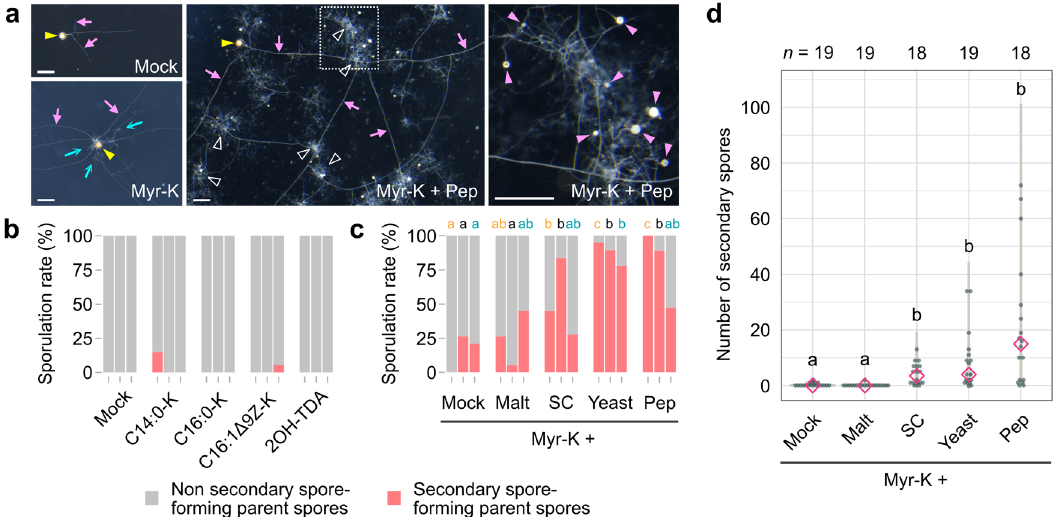
Fig. 1 Effects of fatty acid salts and organic nitrogen sources on asymbiotic cultures of R. clarus . a Effects of potassium myristate (Myr-K) and peptone (Pep) on R. clarus growth. AM fungi were incubated in a medium with or without 100 μ M Myr-K and 0.2 g l − 1 peptone for 6 weeks. Branched hyphae (blue arrows) were observed around a parent spore (yellow arrowhead) in a medium containing Myr-K. Small, white spores were formed among densely packed coils (DPCs, outlined arrowheads) in a medium containing both Myr-K and Pep. The rightmost picture is a magni fi ed image of the dotted box in the middle picture. Pink arrowheads indicate newly generated secondary spores. Pink arrows indicate runner hyphae. Bars = 500 µ m. b Sporulation rates, percentage of secondary spore-forming parent spores relative to germinated parent spores, in cultures supplemented with 100 μ M fatty acid at 6 weeks after incubation (WAI). Three bars in each condition are trials 1 – 3, respectively, from the left. 2OH-TDA 2-hydroxytetradecanoic acid. C14:0-K potassium myristate. C16:0-K potassium palmitate. C16:1 Δ 9Z-K potassium palmitoleate. c Sporulation rates in cultures with 0.2 g l − 1 organic nitrogen source in the presence of Myr-K at 6 WAI. Different letters above of the graph indicate signi fi cant differences among treatments in each trial using Fisher ’ s exact test with Bonferroni correction ( p < 0.05). Malt, malt extract. SC, SC dropout. Yeast, yeast extract. d Numbers of secondary spores generated from a single parent spore in medium supplemented with each organic nitrogen in the presence of Myr-K at 6 WAI. Diamonds indicate medians. Statistical signi fi cance was calculated using the Wilcoxon rank-sum test with Bonferroni correction. Different letters indicate signi fi cant differences ( p < 0.05) . p -values are described in Supplementary Data